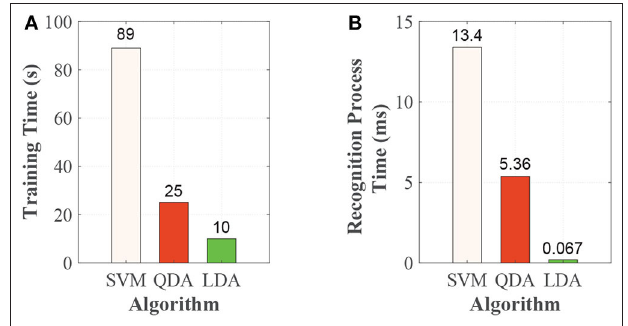
FIGURE 6 | The time performances based on SVM, QDA, and LDA. ( A ) Training time and ( B ) Recognition process time.